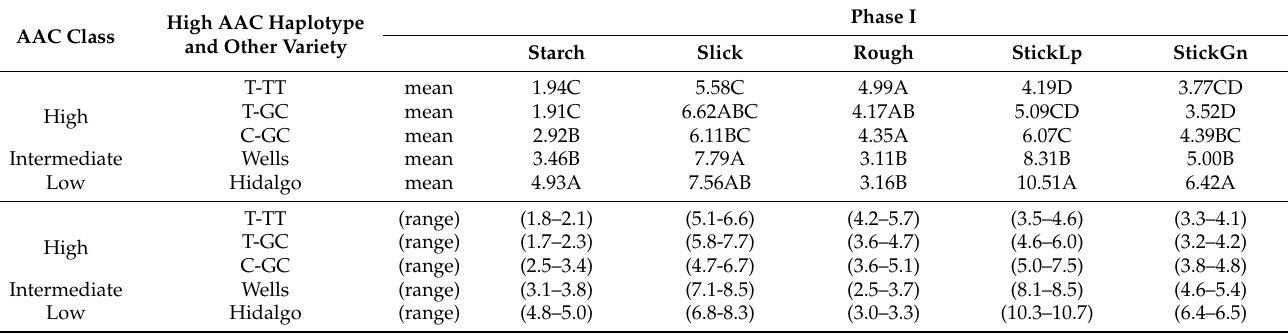
Table 5. Cooked rice texture attributes of 3 high amylose haplotypes, Wells and Hidalgo † .